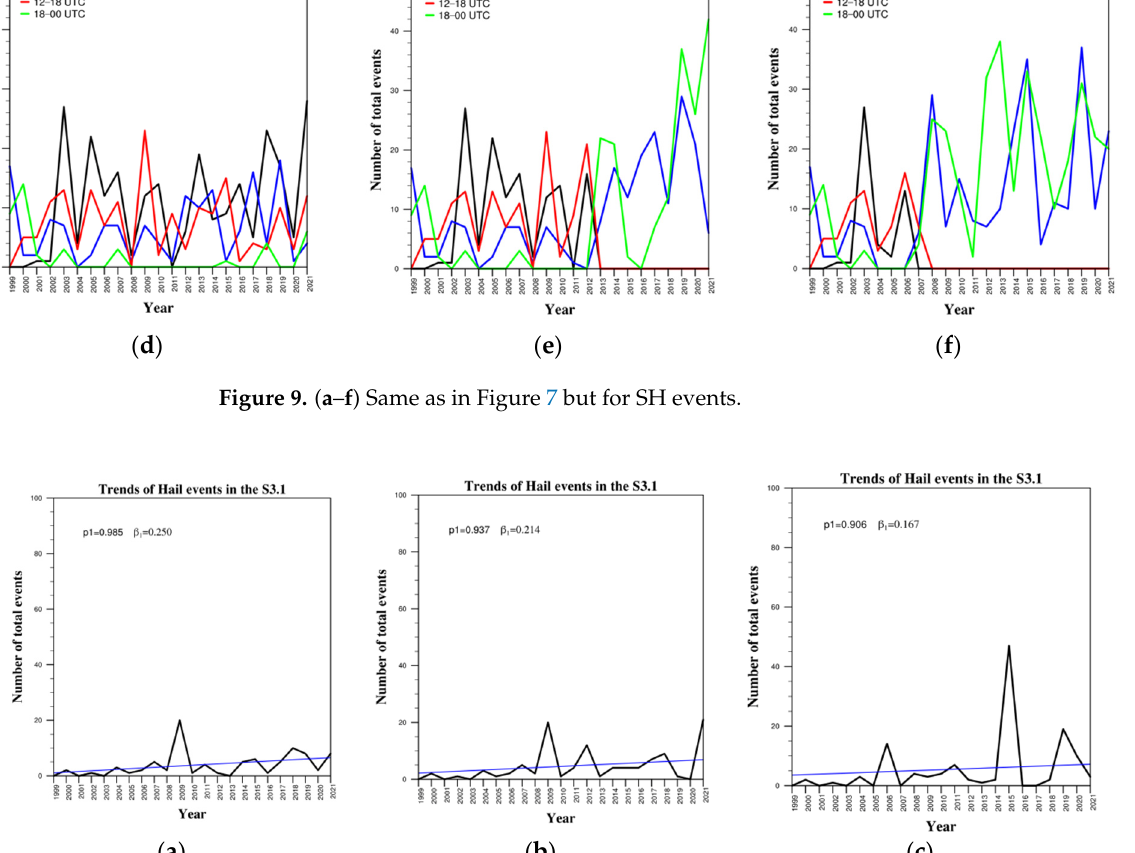
( b ) Figure 11. Temporal evolution of the annual number of H events for the sector 2.1 considering the time series-2 N15-N18-MOB ( a ), and time series-3 N15-MOA-MOC ( b ). Blue line displays the ten- dency of series.